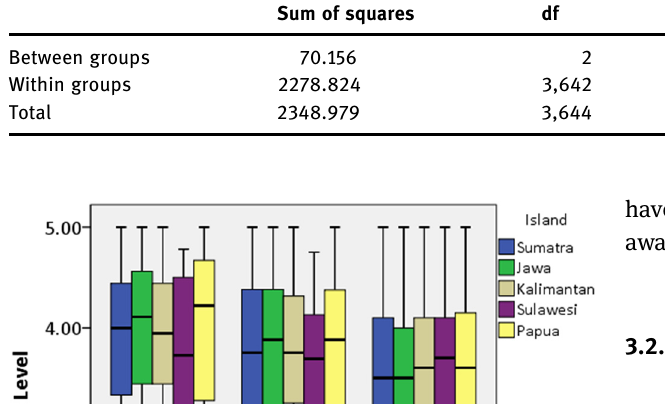
Table 18: Analysis of variance of awareness level by parents ’ job Sum of squares